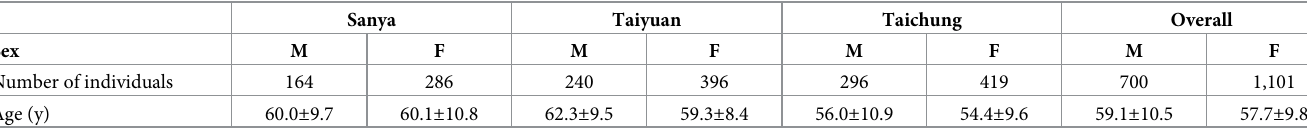
Table 1. Number and mean age of the subjects in each region.